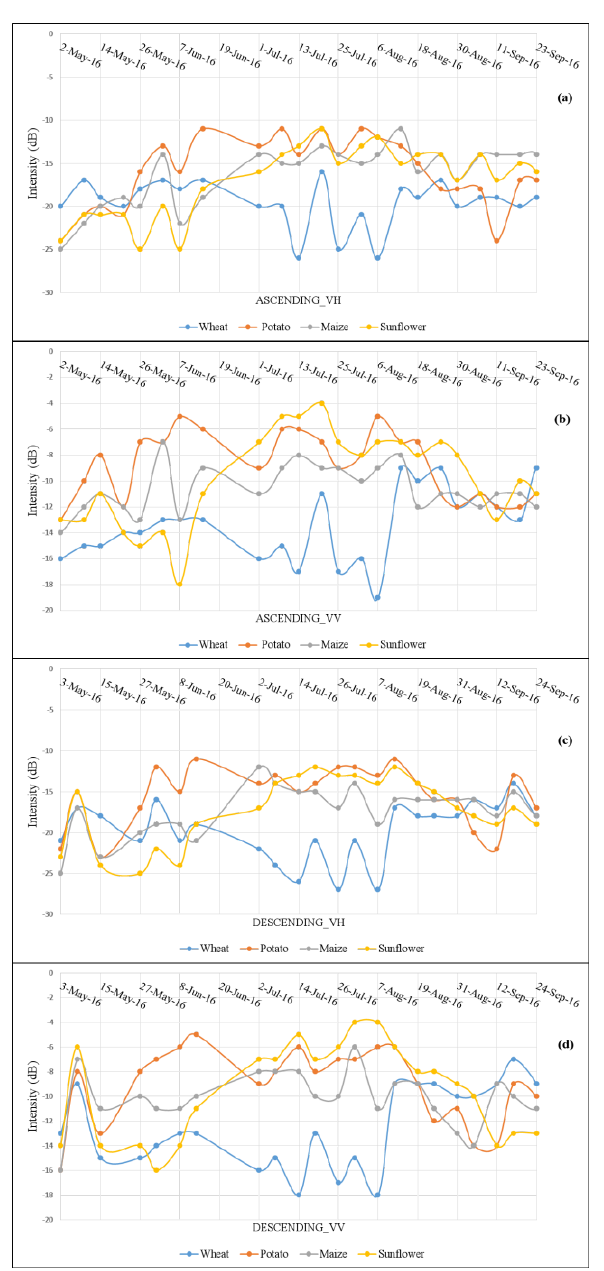
Figure 4. The backscatter value of maize, sunflower, wheat and potato on multi-temporal Sentinel-1 images, (a, b) ascending and (b, c) descending in VH and VV polarization respectively In Figure 4, backscatter value of all crop types at the early stages of the crops present a relatively homogenous intensity values. Whereas in the growing stages (mid stage) of the crops, due to differences in physical structure of the crops and the